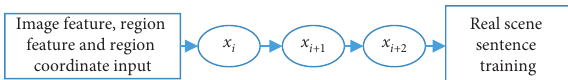
Figure 4: LSTM-based real-world lexical sentence formation